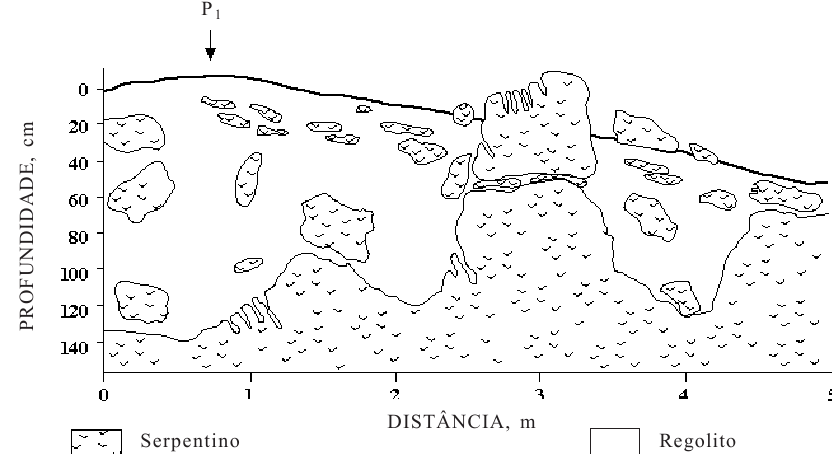
Figura 3. Perfil lateral avaliado em trincheira do regolito no topo da colina estudada em Fortaleza de Minas (MG). Notem-se a variação de espessura e o fendilhamento tanto na superfície do bloco de rocha aflorante como em algumas posições na transição rocha/solo (microrrelevo pseudocárstico característico de rochas que sofrem dissoluções